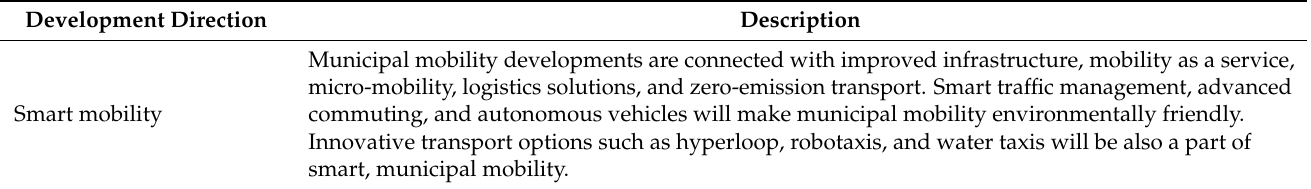
Table 7. A cumulative list of smart city fundamental development directions—StartUS Insights’ view